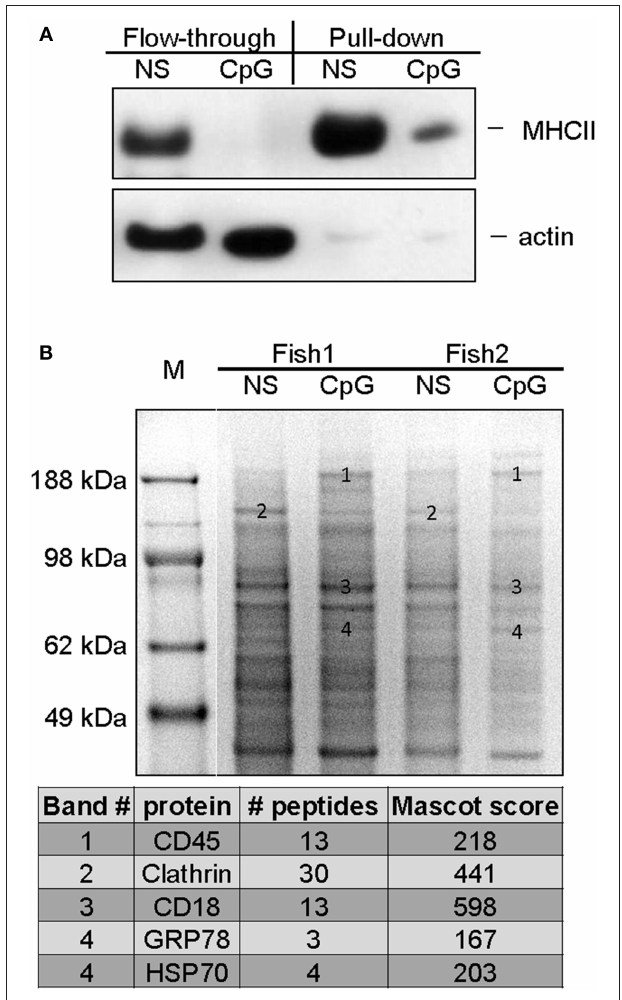
FIGURE 7 | Mass spectrometry analysis of cell surface proteins of non-stimulated and CpG-treated salmon MPs. The cells were either left non-stimulated or were stimulated with CpGs for 7 days. Cell surface proteins were labeled with biotin and purified as described in Materials and methods. (A) The efficiency of the cell surface protein purification was confirmed with WB analysis. Flow-through and pull-down samples enriched in proteins associated with cell surface from control non-stimulated and CpG-stimulated cells were run on SDS PAGE and protein levels of MHCII- β and actin were detected with polyclonal antibodies. (B) Samples enriched in cell surface proteins isolated from cells of two individuals were run in parallel on SDS-PAGE, and stained with Coomassie. Bands of interest were excised, and subjected to MS/MS analysis. The table below the gel image lists identified proteins in bands whose ID numbers are indicated on the gel